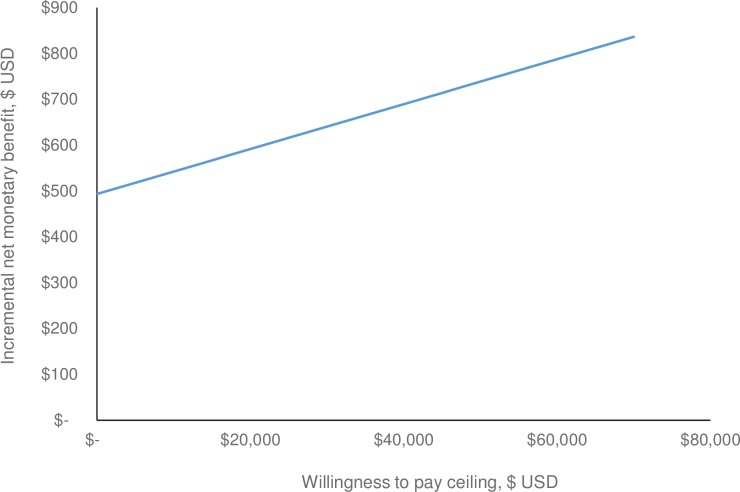
Net benefit curve.